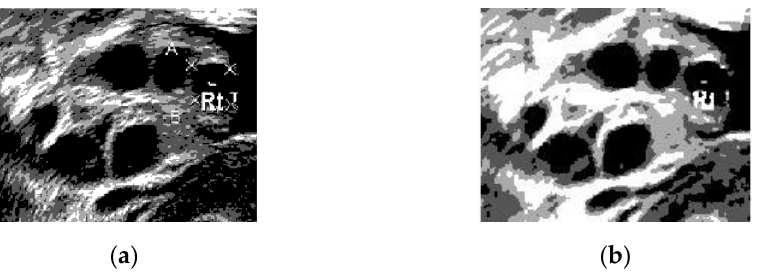
Figure 11. ( a ) Original ultrasound image, ( b ) ultrasound image after Otsu’s thresholding with a grayscale threshold level of 4.